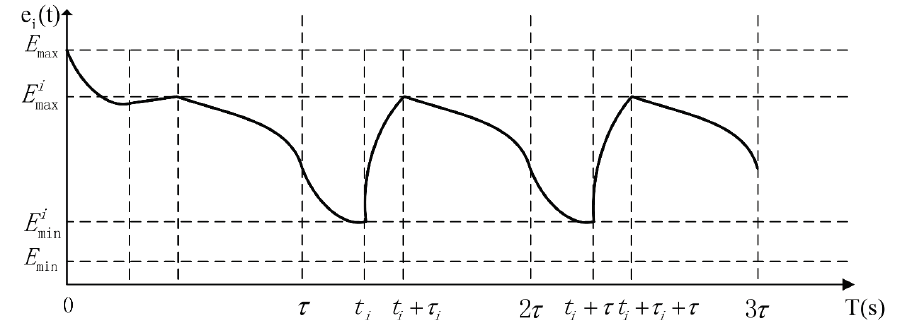
Figure 4. The energy-time curve of a sensor node in pre-normal replenishing stage, the first and the second normal replenishing